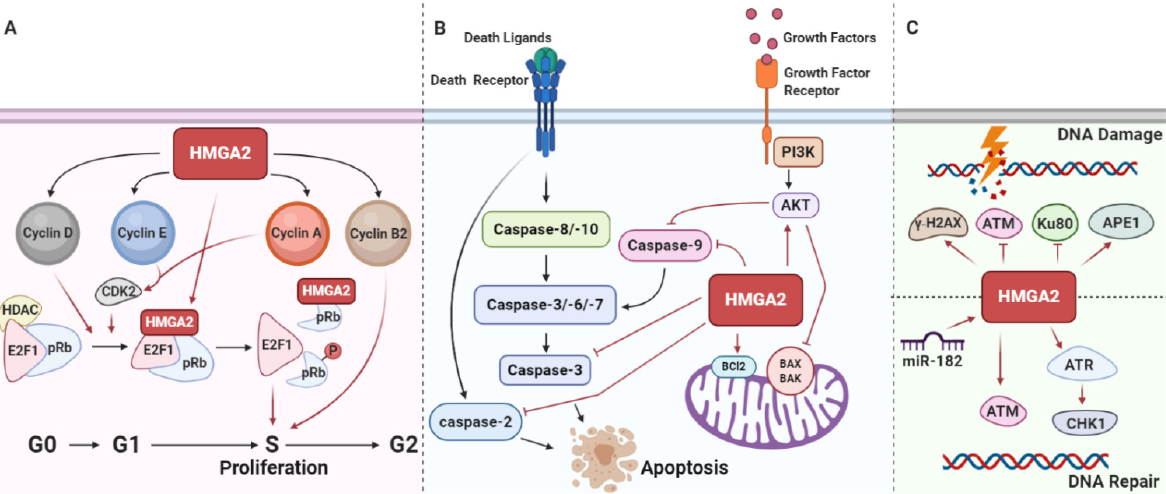
Figure 4. HMGA2 promotes cancer cell proliferation, inhibits apoptosis, and differentially affects DNA damage repair. ( A ) HMGA2 activates cyclin D1, cyclin E, and cyclin A and promotes pRB phosphorylation. This releases E2